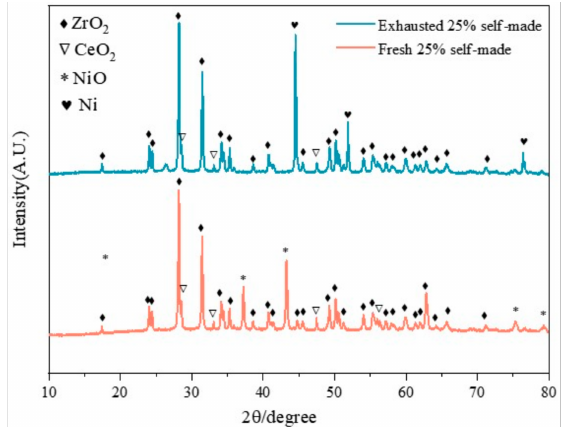
Figure 11. XRD characterization of synthetic catalysts before and after catalytic reforming process.